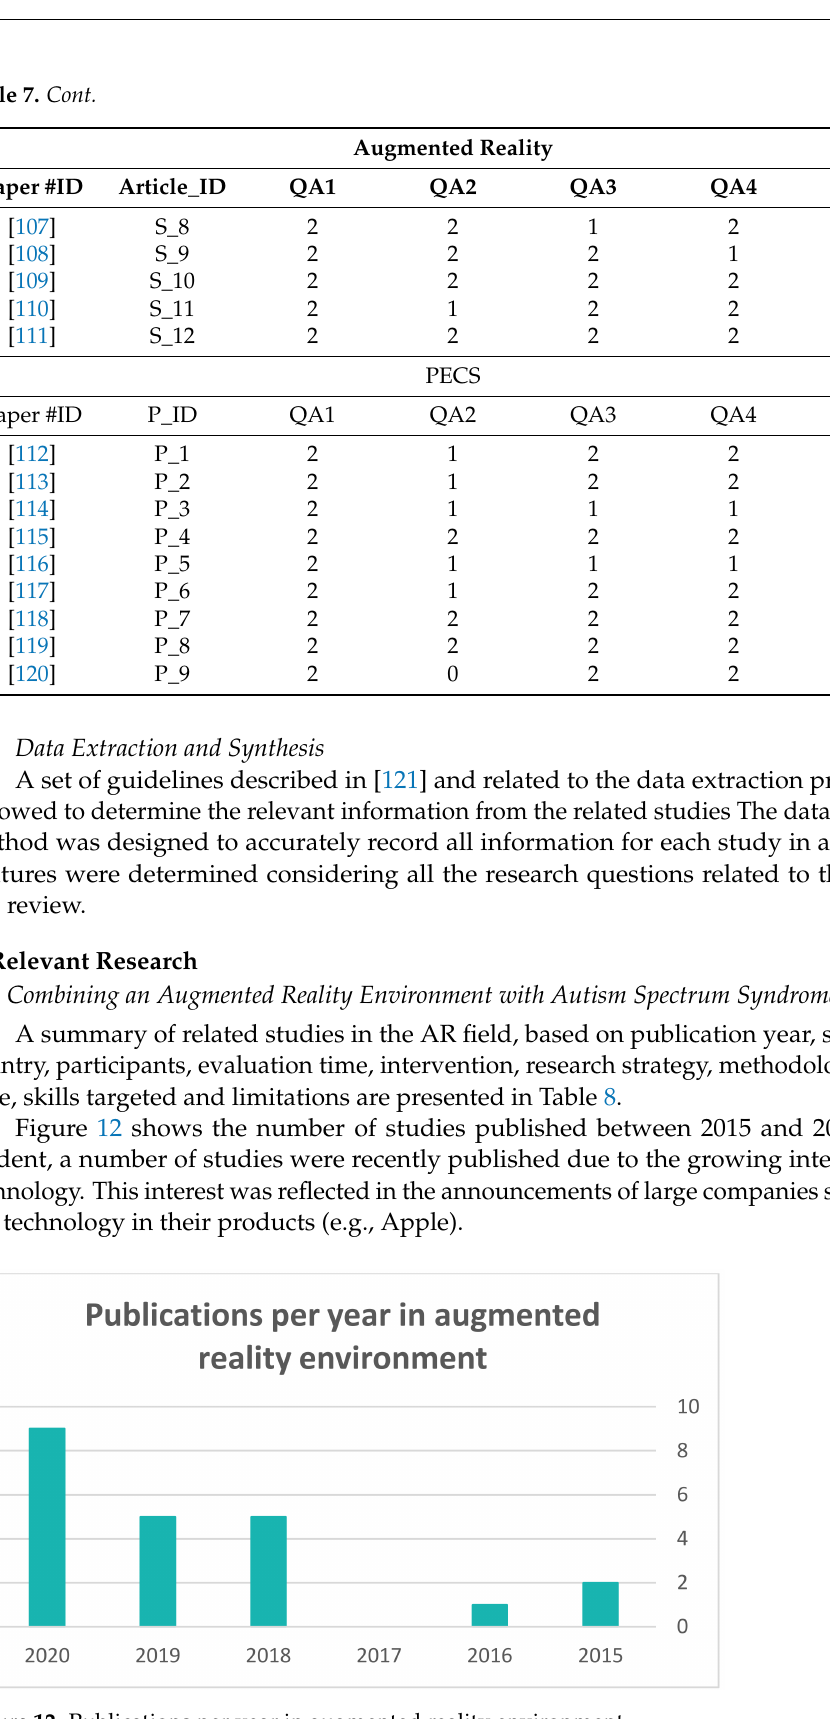
Figure 12. Publications per year in augmented reality